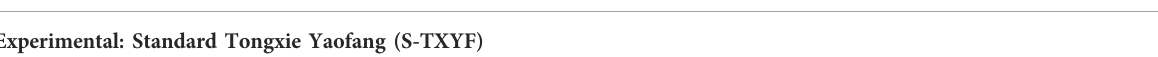
TABLE 2 Summary of evidence certainty for the primary outcome. Patient or population: Adult patients with diarrhea-predominant irritable bowel syndrome Setting: Outpatients and wards Experimental: Standard Tongxie Yaofang